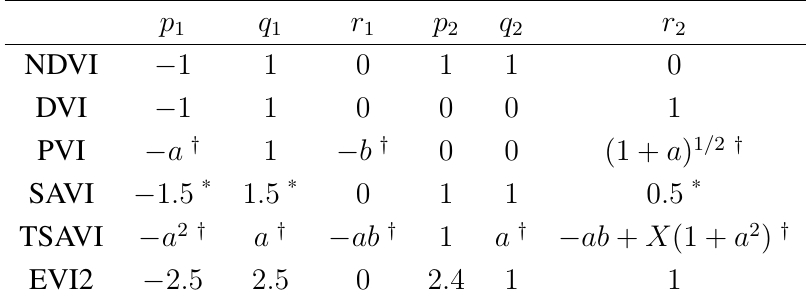
, q and r ) used in this study. i i i